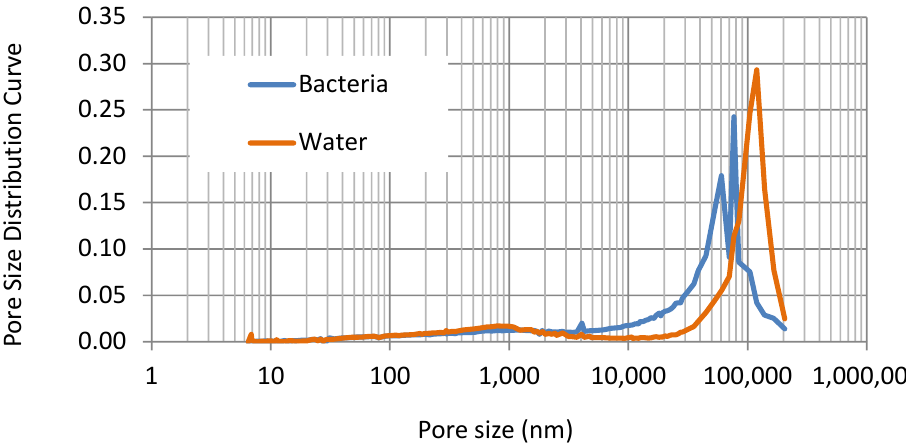
Figure 5. Pore size distributions of the samples tested (bacteria—biocemented soil; water—untreated soil in natural state).